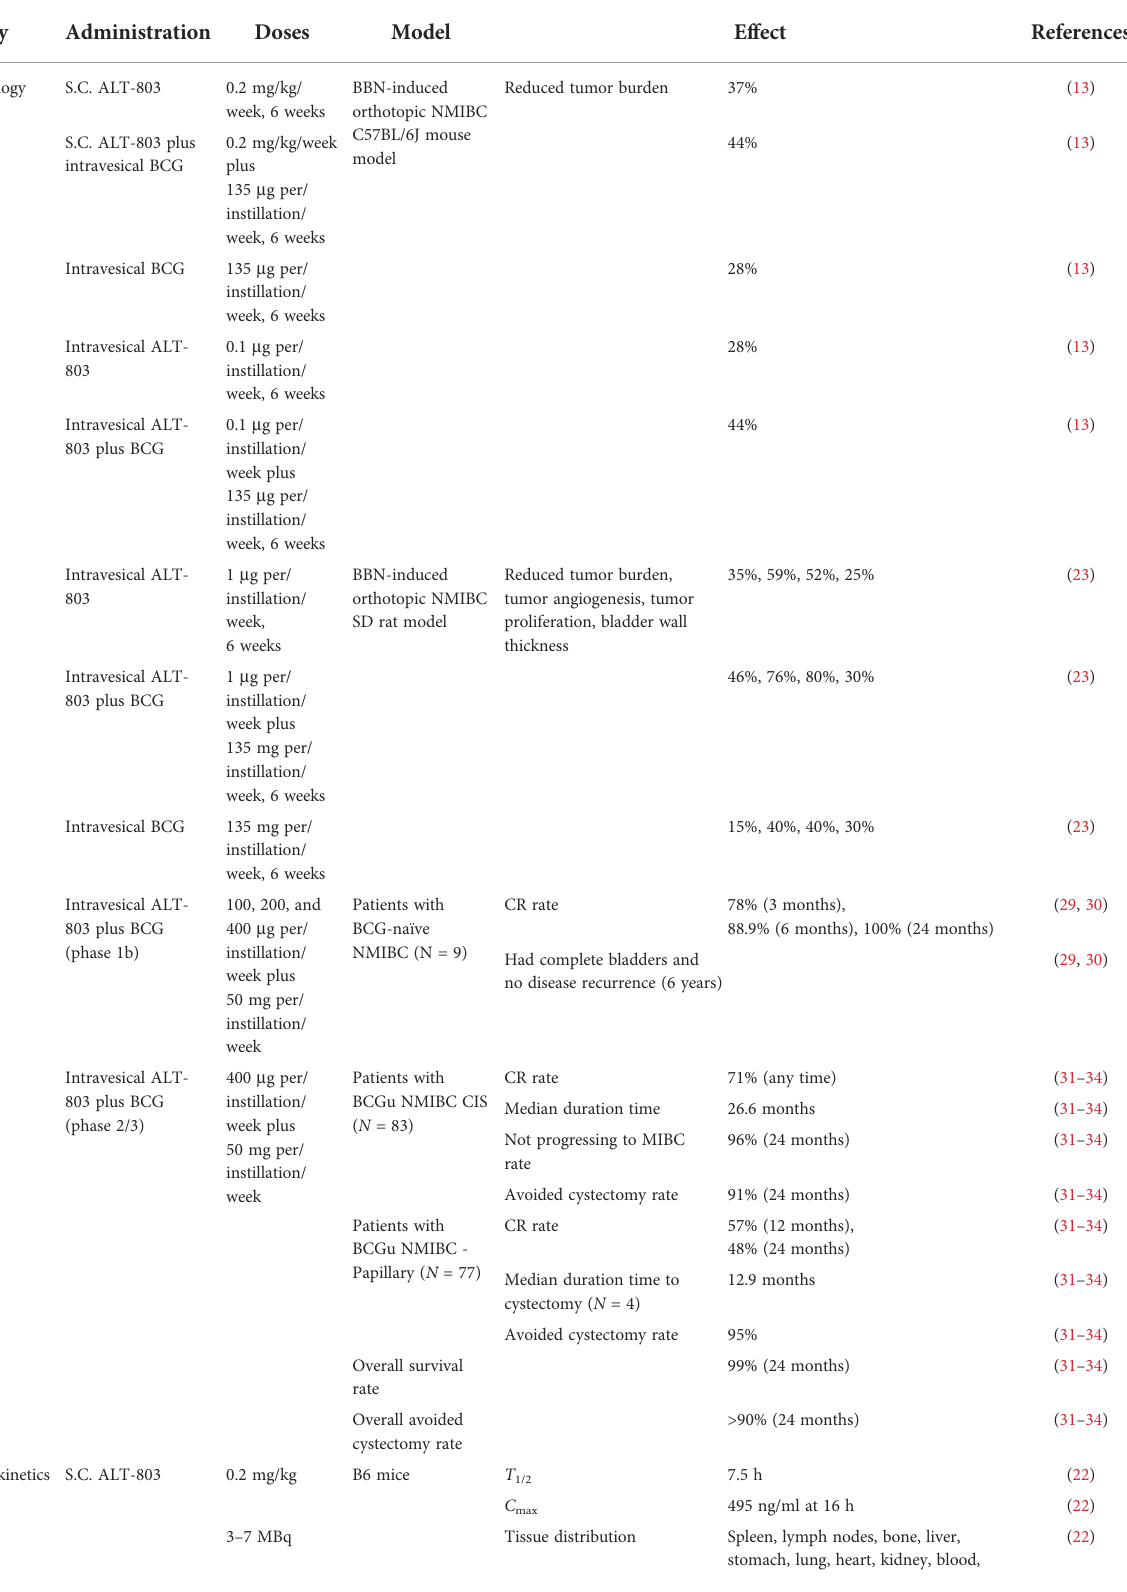
TABLE 1 The preclinical and clinical evidence uses of ALT-803 in